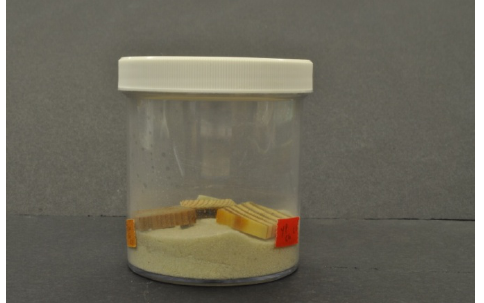
Figure 1. Sample test jar with three different wood